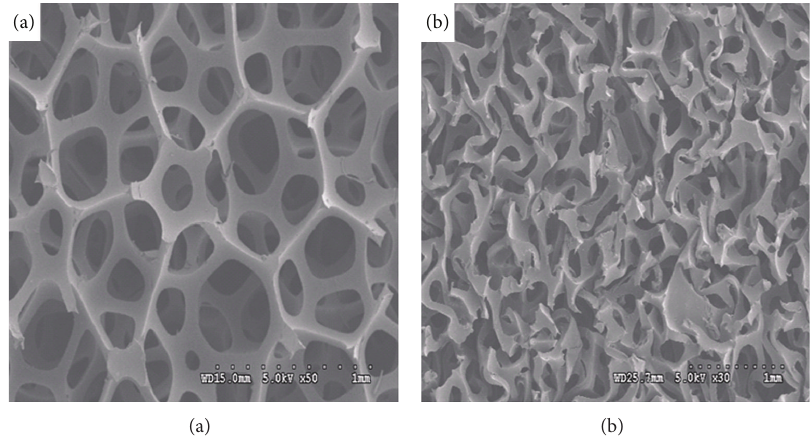
Figure 5: Microstructures of polyurethane scaffolds: (a) a control specimen and (b) an experimental specimen.